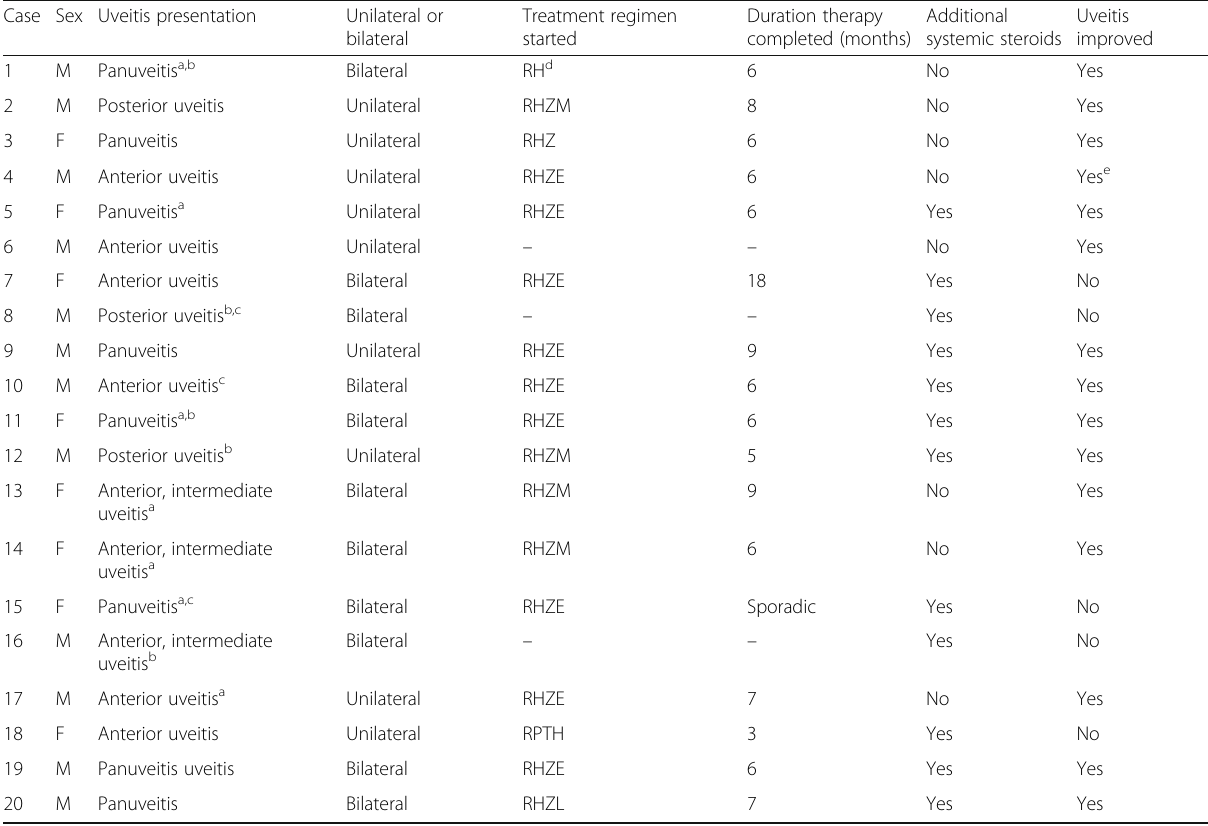
Table 2 Clinical presentation, treatment details, and clinical outcomes of 20 study patients Case Sex Uveitis presentation